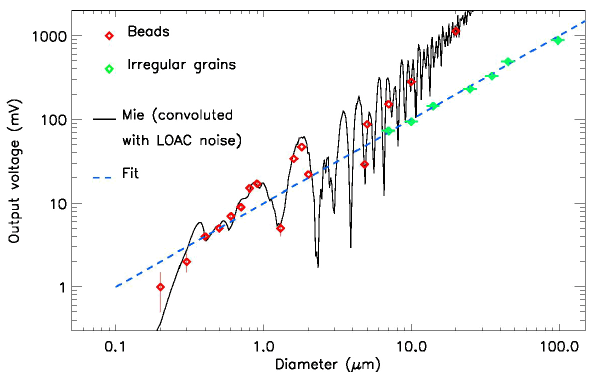
Figure 4. Calibration curve of the output voltage recorded by the 12 ◦ channel photodiode as a function of particle diameter. Beads were used in the 0.2–5.0µm range; irregular grains selected by sifters were used for the largest size. The Mie calculations were conducted for the LOAC field of view, and were convoluted by the LOAC electronic noise for particles smaller than 0.6µm. The differ- ence between the Mie scattering calculations and LOAC measure- ments for diameters greater than 5µm is due to the small aperture of the field of view coupled with the roughness of the particle shapes; the measurement curve is fitted by a power law.